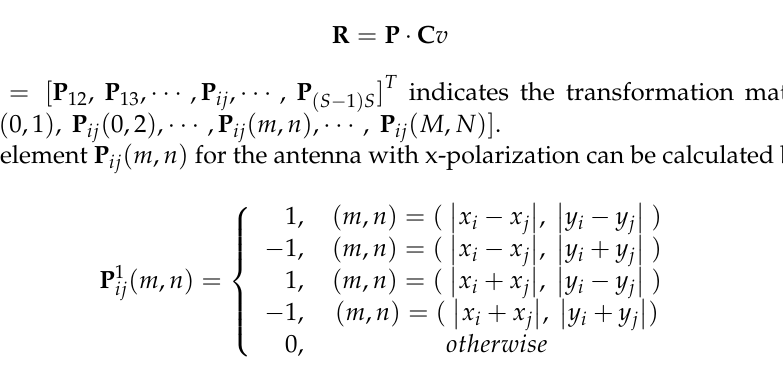
Table 3. The Ranks of the First Case.